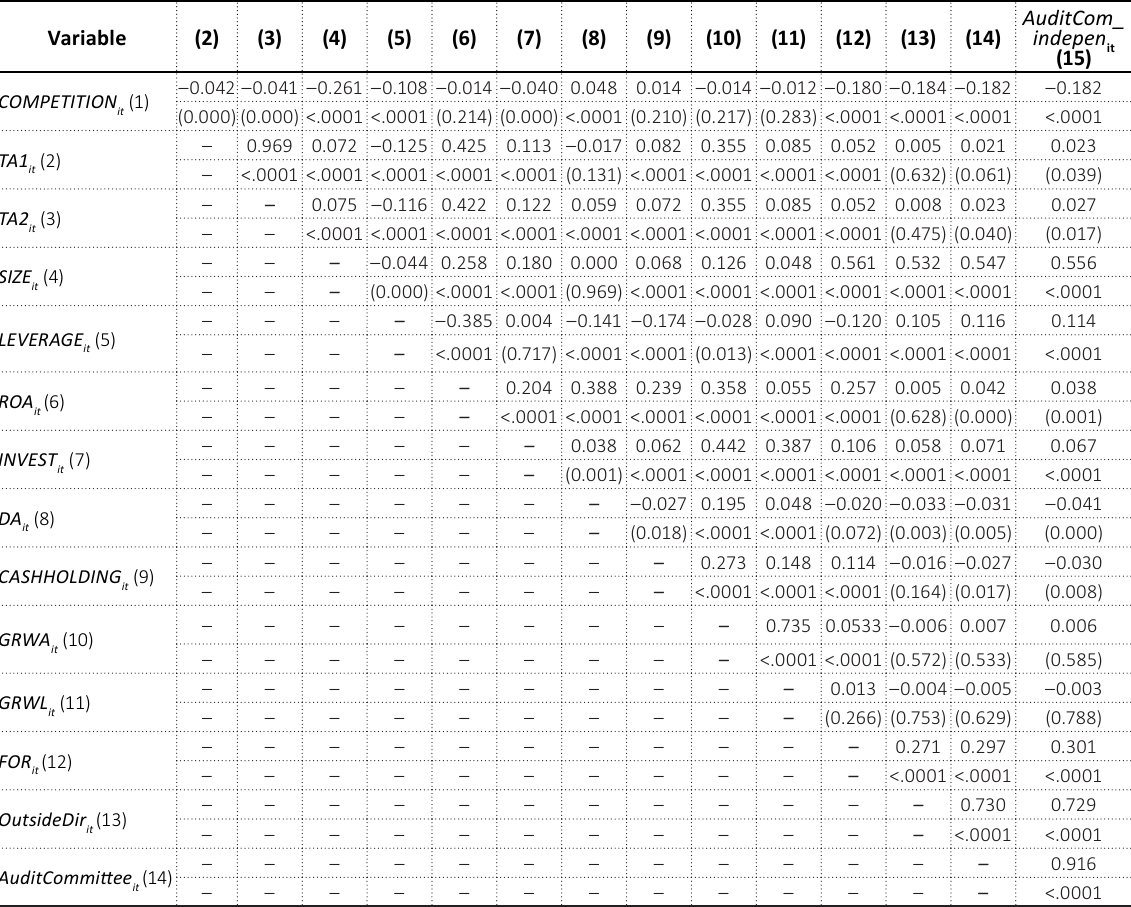
(2) for two sub-samples: high board independence versus low board independence. We measure the board independence as the proportion of outside directors on the board and classify the firms with board independence above (below) the median as high (low) board independence group. Our sec- ond hypothesis predicts that the negative relation- ship between product market competition and tax avoidance will be more pronounced for high board independence group than low board inde- pendence group.